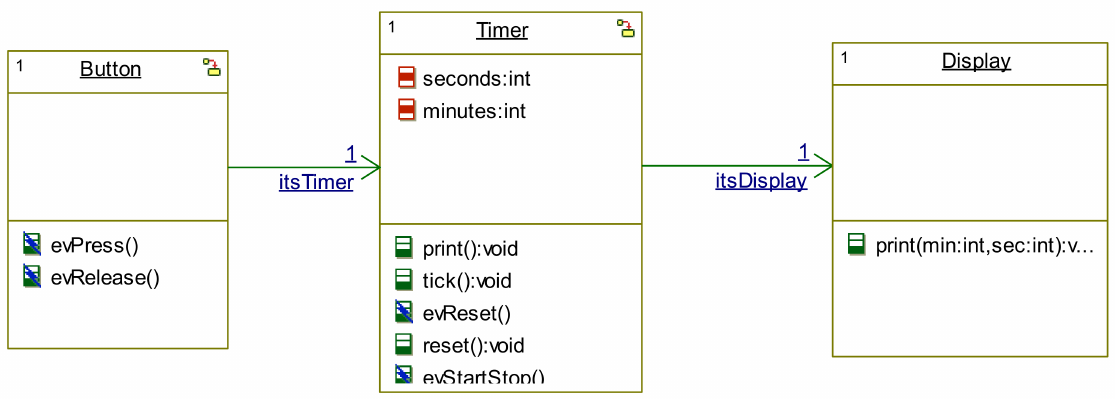
Figure 6. Object Model Diagram of the Stopwatch